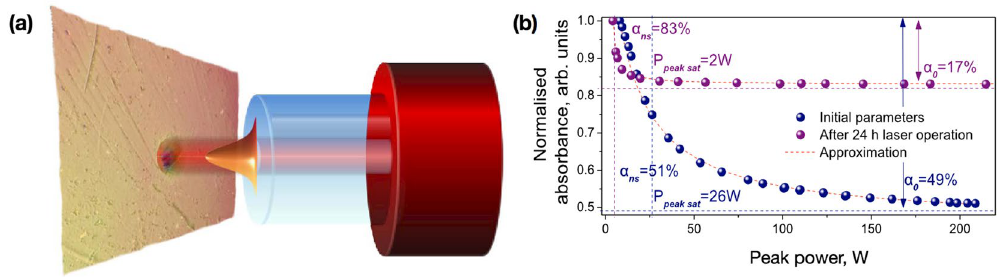
Figure 2. ( a ) Schematic representation of the SWNT-PVA film exposure to high-power fibre laser radiation. ( b ) Power-dependent measurements of the SWNT-PVA film before (blue) and after (purple) laser operation at the maximum available pump power P pump = 600 mW. The circles are the experimental data and the dashed curves represent an analytical fit of the